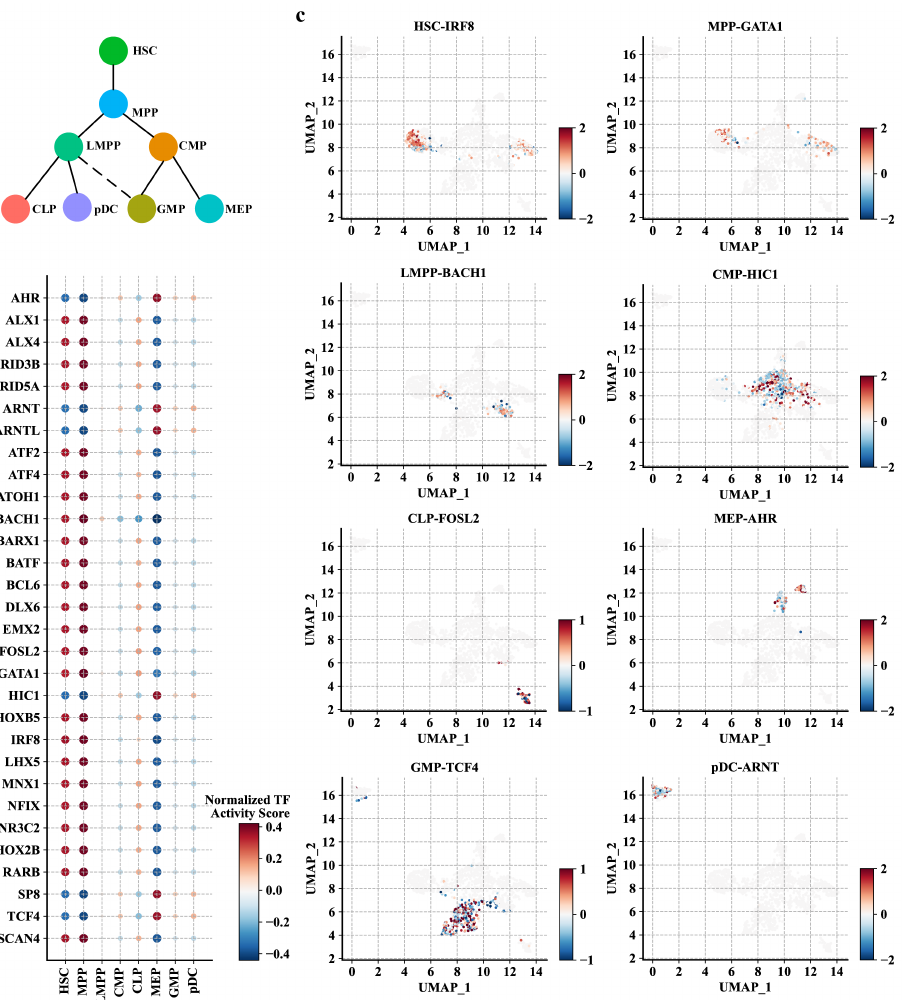
Figure 5. Performance of PROTRAIT in inferring single-cell TF activity. ( a ) HSC differentiation lineage diagram. ( b ) The normalized average activity scores of 30 TFs in eight cell types. ( c ) UMAP represents the single-cell activity scores of the most active TFs in eight cell